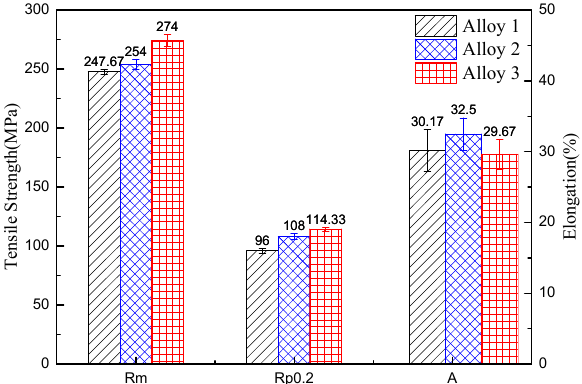
Figure 8. The mechanical properties of the as-cast Al-Mg alloys.